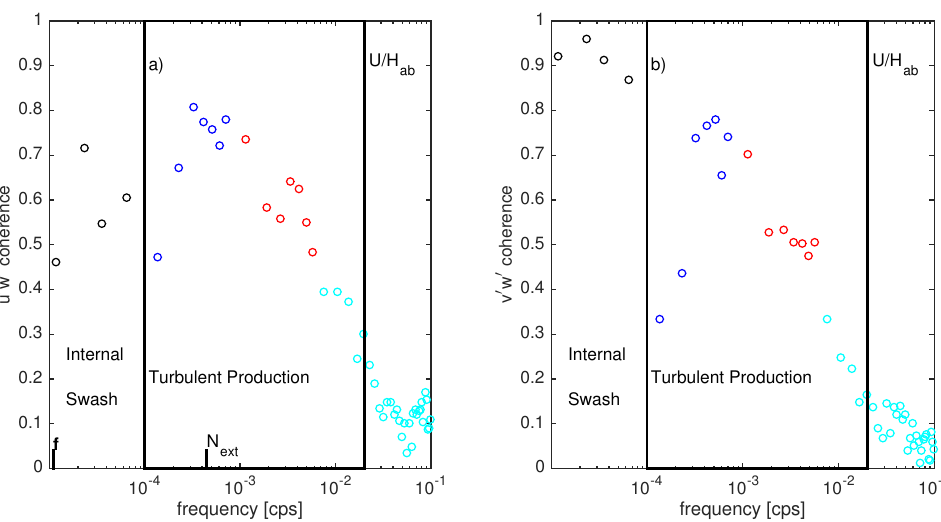
Figure 11. ( a ) u (cid:48) w (cid:48) and ( b ) v (cid:48) w (cid:48) coherences. Note the similarities within the ‘turbulent production’ and higher frequency ‘inertial subrange’ regimes and the difference within the ‘internal swash’ regime. The high meridional coherences within the ‘internal swash’ regime are interpreted as a coupling with internal wave motions directed